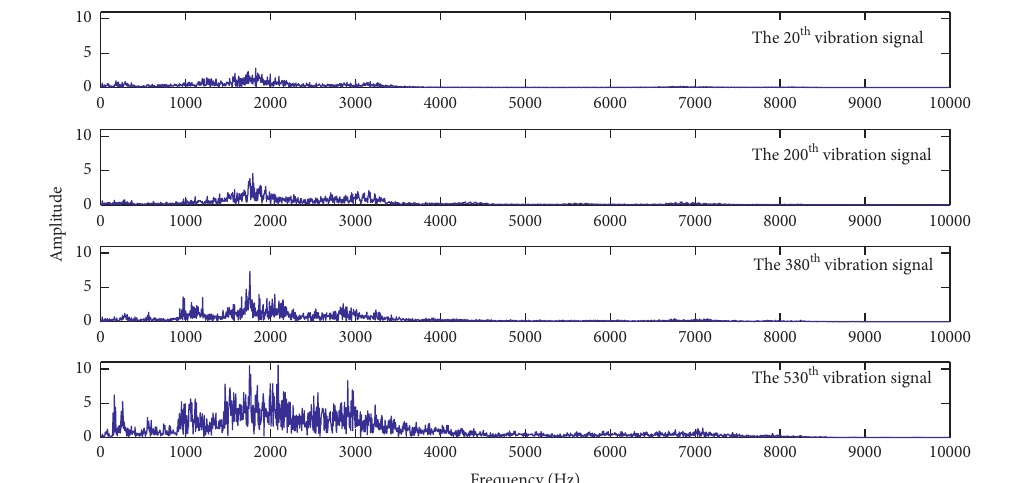
Figure 10: Frequency spectrum of vibration signals X